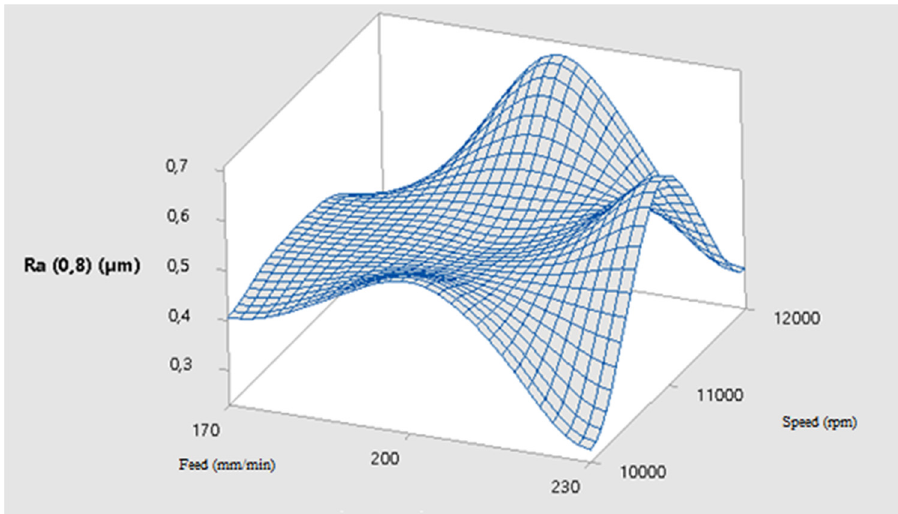
Figure 10: E ff ects of feed and rev on surface